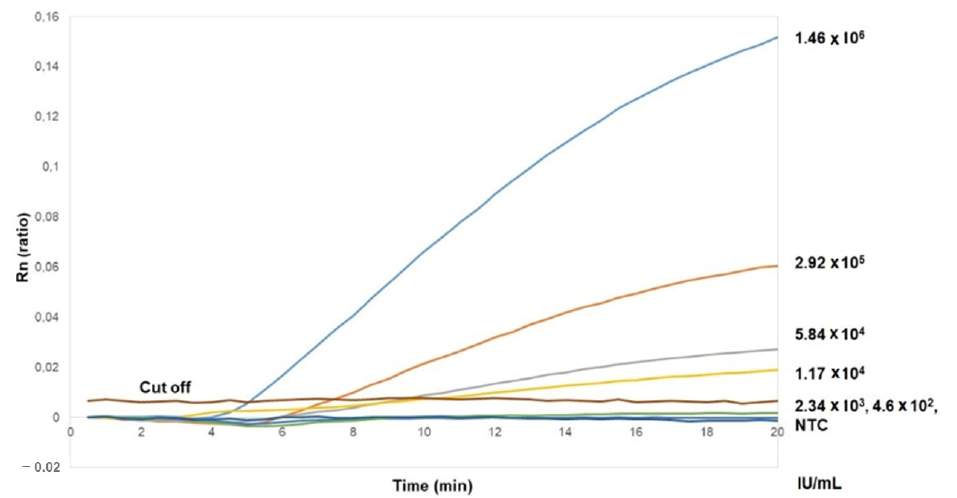
Figure 2. Detection limit of the HBV RPA Exo test. Amplification curves for five-fold serial dilutions ranging from viral loads of 1.46 × 10 6 IU/mL to 4.6 × 10 2 IU/mL. Each point of the curve represents the mean of two replicates. Rn corresponds to the ratio of FAM to ROX fluorescence. NTC refers to non-template control.